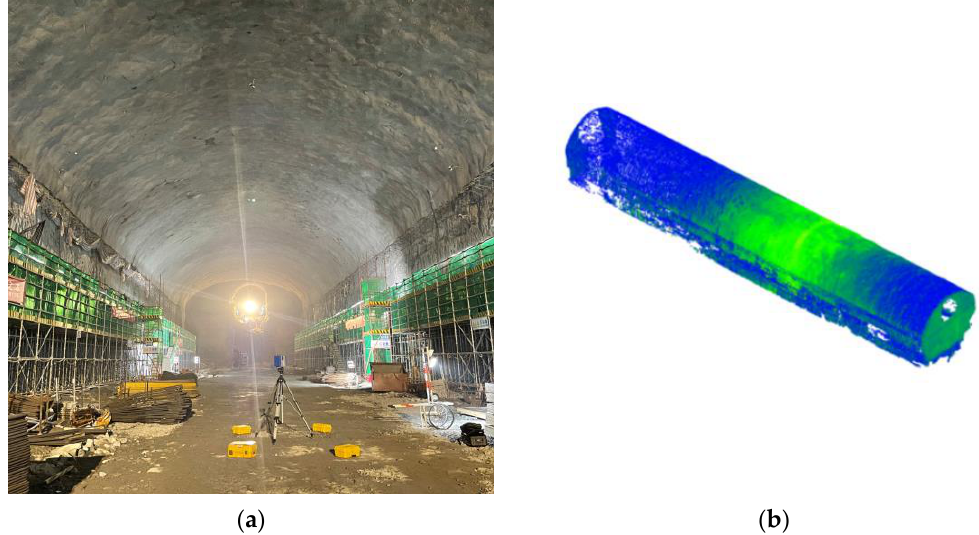
Figure 2. Experimental data acquisition. ( a ) Data acquisition site. ( b ) Raw point cloud.